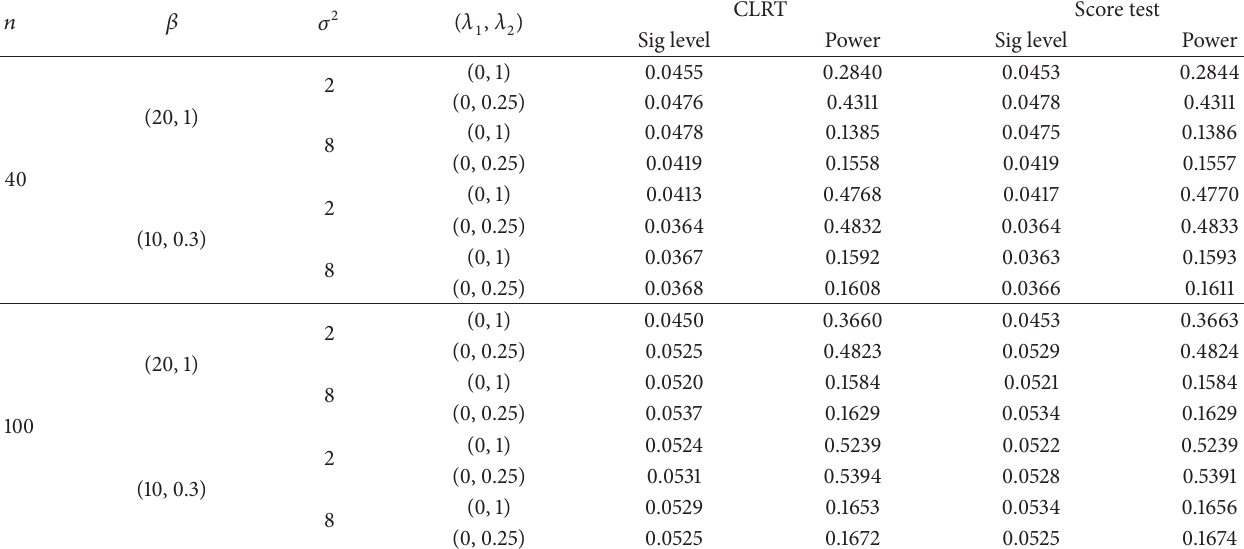
Table 2: The probability of a type Ι error ( 𝛼 = 0.05 ) and power of CLRT and score test statistics for a variance shift model in a linear measurement error with combination different of parameters 𝛽 , 𝜎 2 , Λ , and 𝑏 = 3